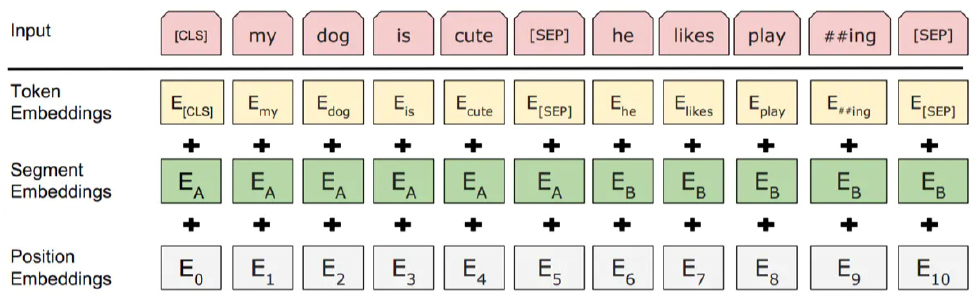
Figure 1. the structure of BERT